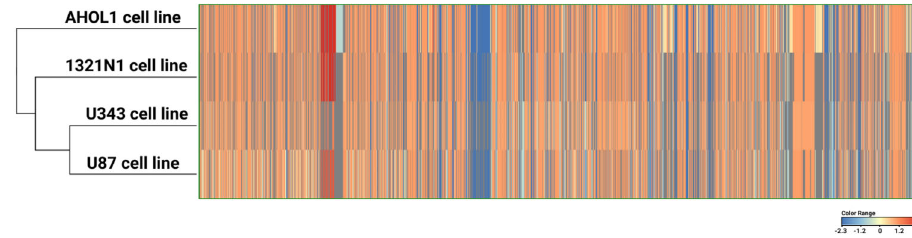
Figure 3. Heatmap of all copy number alterations present in each cell line (AHOL1, 1321N1, U343, and U87).